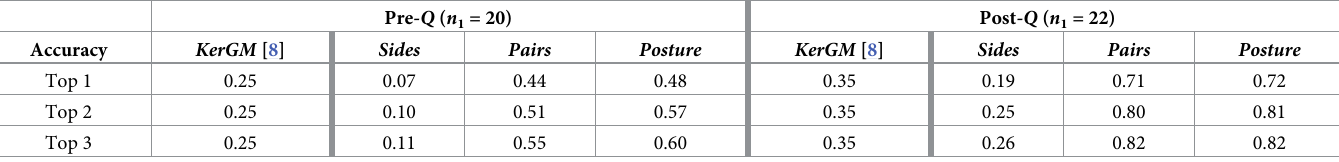
Table 2. Hypergraphical models leveraged Q neuroblasts to more accurately identify posture. The samples were split according to the absence (left) or presence (right) of the Q neuroblasts, which form in the last two hours of development. There were 875 n 1 =20 cell (pre- Q ) samples and 389 n 1 =22 cell (post- Q ) samples. Hypergraphical models Pairs and Posture more accurately identified posture in the post- Q samples than the pre- Q samples, suggesting the increased continuity along the body enhanced posture